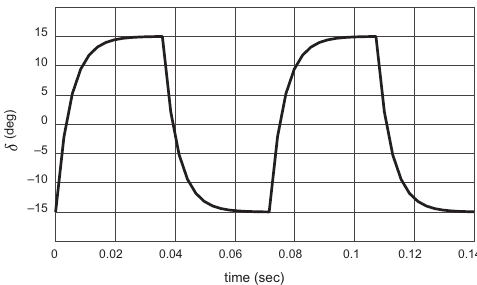
Figure 3. Time history of real ON-OFF